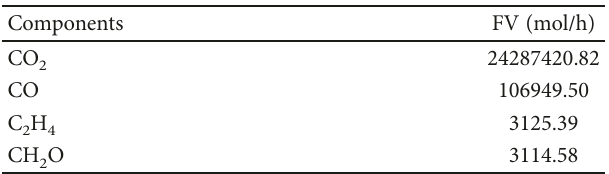
Figure 10: Typical concentration distribution in four seasons. Table 3: The emission factor of CO , CO, and NM-VOCs. Table 4: Typical fl ux 2